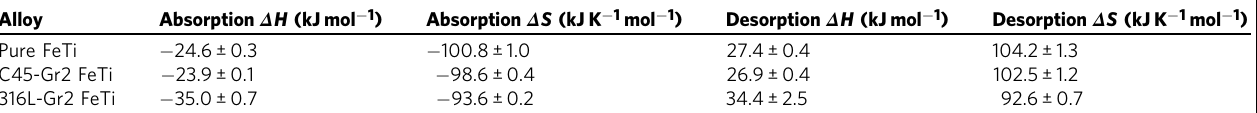
Table 2 Thermodynamic properties of pure FeTi, C45-Gr2 FeTi, and 316L-Gr2 FeTi alloys.